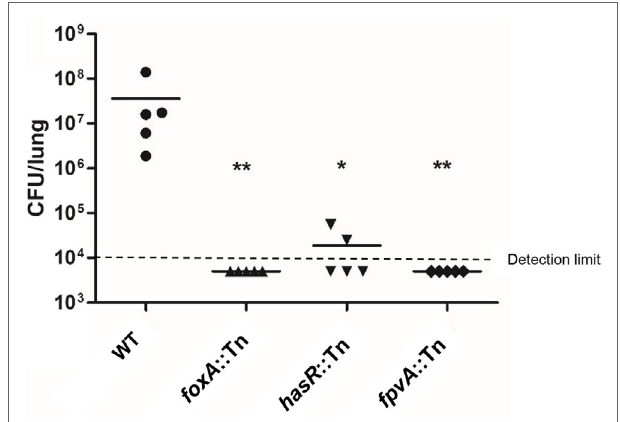
FigUre 3 | Bacterial colonization in the murine acute pneumonia model. Each mouse was infected by 2 × 10 7 CFU of the indicated strain intranasally. 12 h after infection, mice were sacrificed and bacterial loads in the lungs were determined. Bacterial loads in mice infected with wild-type PA14 and the oprH :Tn, foxA :Tn, hasR :Tn, and fpvA :Tn. Bars represent medians, and error bars represent SEM. * p < 0.05; ** p < 0.01 compared to wild-type PA14 by the Kruskal–Wallis with Dunn’s multiple comparison test. NS, not significant.